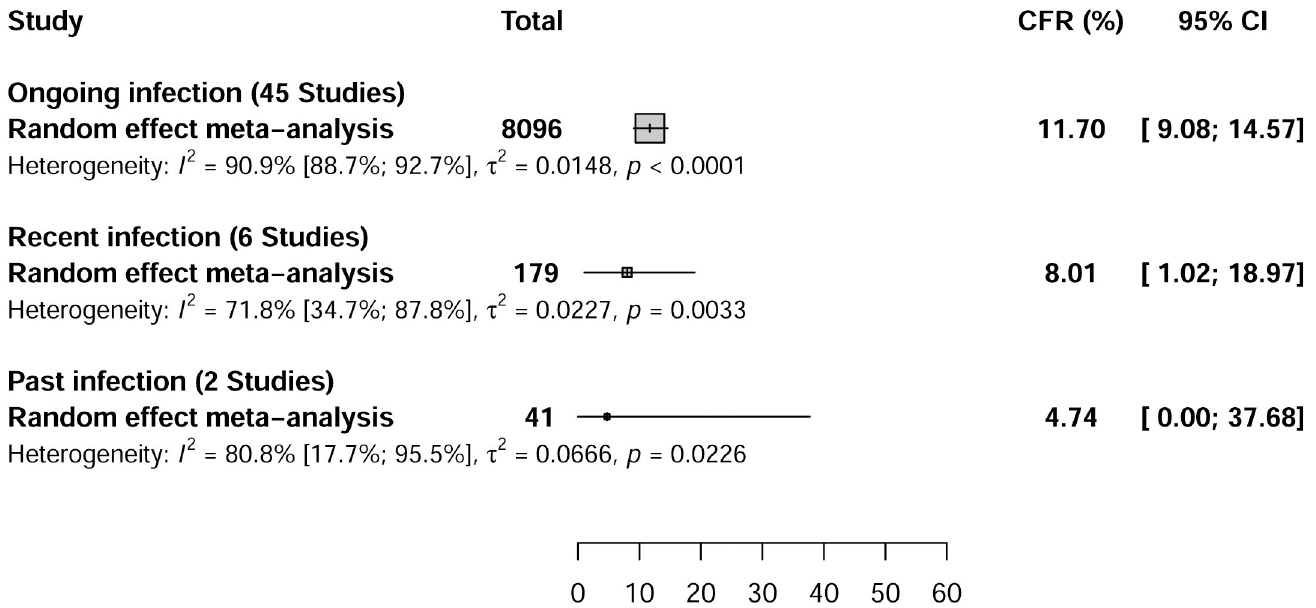
Fig 2. Global case fatality rate estimate of Crimean-Congo hemorrhagic fever virus infections in humans.